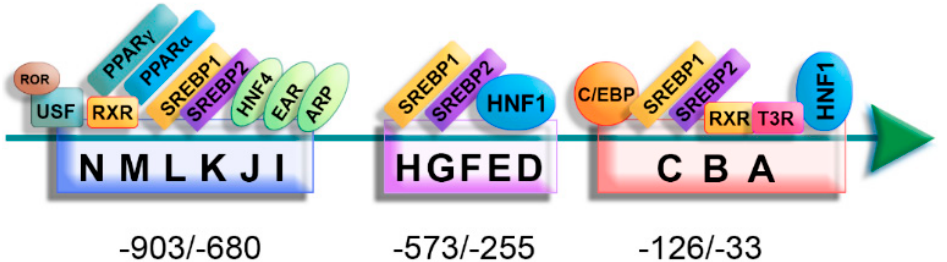
Figure 2. Regulatory elements and transcription factors for ApoA-II gene expression control. The regulatory elements within the ApoA-II promoter are: (i) proximal (A–C), located in the region -126/-33, (ii) intermediate (D–H), located in the region -573/-255, and (iii) distal (I–N) located in the region -903/-680. ApoA-II expression is regulated by many transcription factors and nuclear receptors, such as ROR (Retinoic Acid-Related Orphan Receptor), USF (Upstream Stimulatory Factor), RXR (Retinoid X Receptor), PPAR (Peroxisome Proliferator-Activated Receptors), SREBP (Sterol Regulatory Element-Binding Proteins), HNF (Hepatocyte Nuclear Factor), C/EBP (CCAAT/enhancer-binding protein), and T3R (Thyroid hormone Receptor).